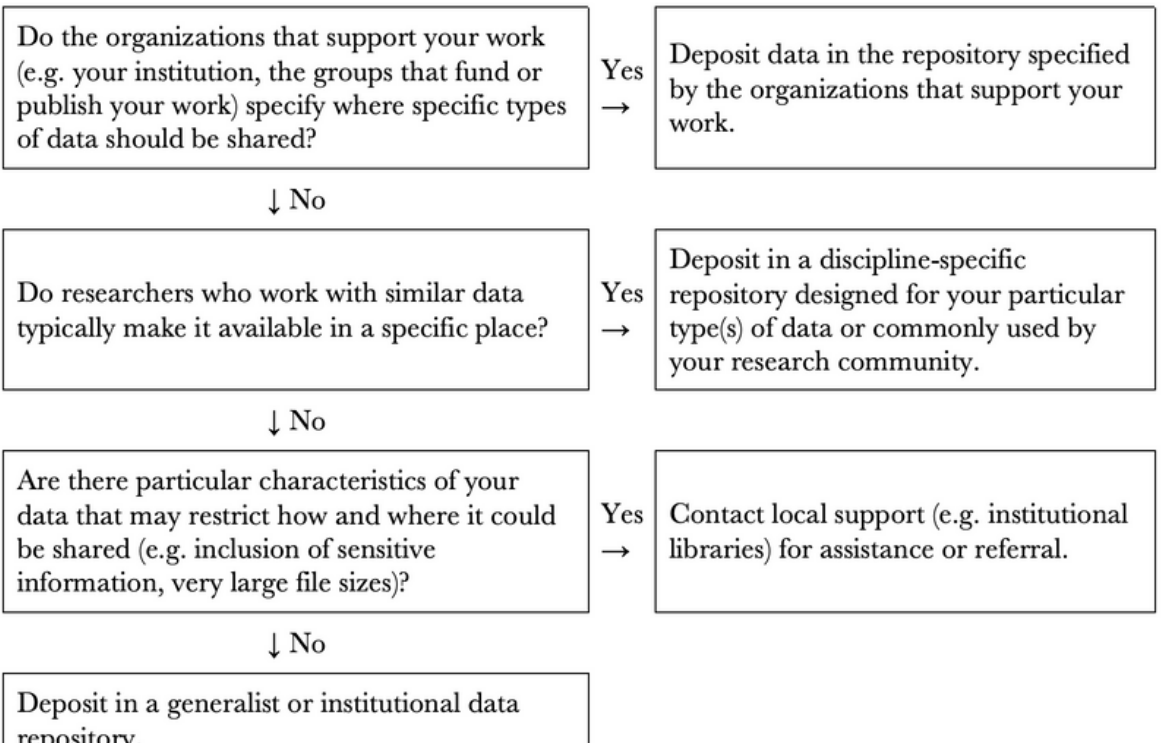
Figure 2. Guidance for researchers when choosing a data repository. The different